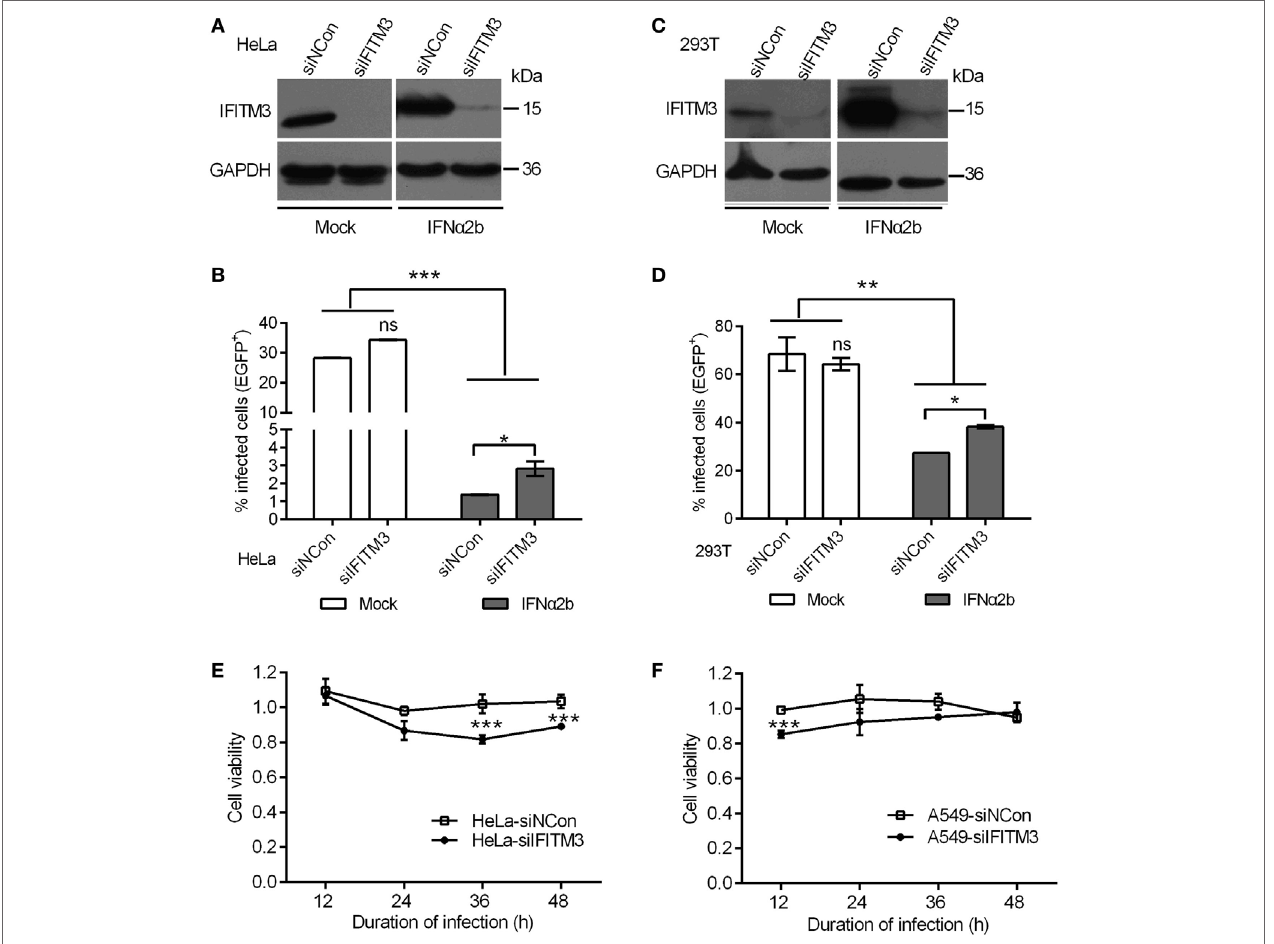
FigUre 2 | Interferon-inducible transmembrane protein 3 (IFITM3) silencing mediates antiviral actions of IFN- α 2b. (a,c) IFITM3 expression was analyzed by Western blot in siRNA-transfected HeLa and 293T cells treated with or without IFN- α 2b. (B,D) Green fluorescent protein (EGFP)-positive cells were scored by flow cytometry of siRNA-transfected HeLa and 293T cells with or without IFN- α 2b treatment at 24 h postinfection by vaccinia virus Tian Tan green fluorescent protein (VTT-EGFP). (e,F) Viability of siRNA-transfected HeLa and A549 cells infected with VTT virus at 0.1 PFU/cell was assessed by MTS assay. Values represent the mean ± SD, n = 4. * P < 0.05, ** P < 0.01, and *** P <